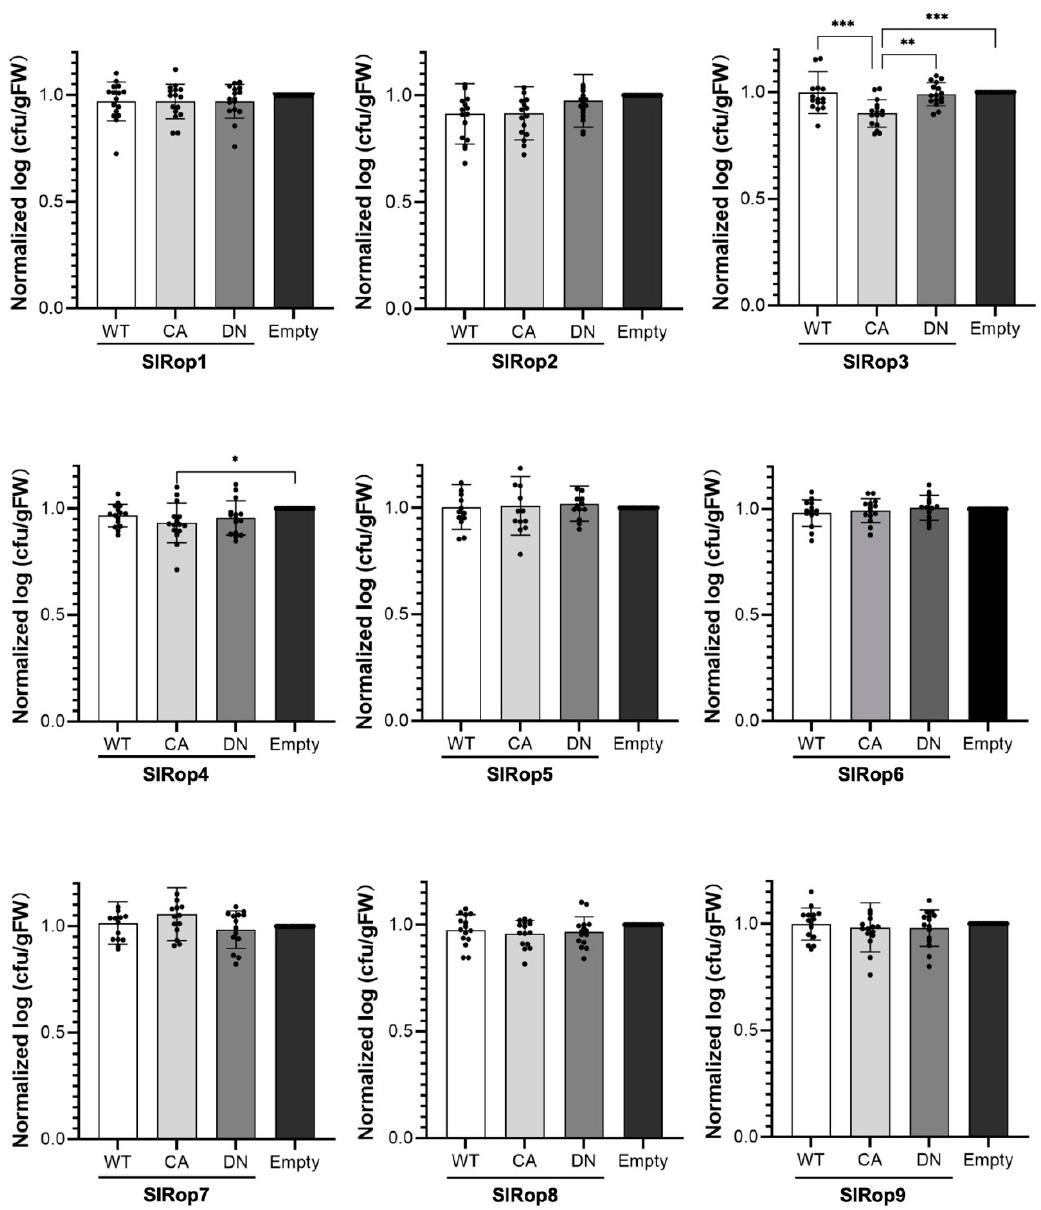
Figure 7. Contribution of SlRop1–9 to defense against R. solanacearum. Effects of tomato ROPs on the virulence of R. solanacearum in N. benthamiana . The R. solanacearum Y45 strain was injected into the regions overexpressing different activation states of 35S promoter-driven SlRop1–9. By 2 dpi, the extractions from inoculated leaves were spread on the medium. The number of bacteria towards plant fresh weight was calculated and then converted to a logarithmic scale. Bars indicate the growth of Y45 relative to that determined in negative control Empty. WT, wild type; CA, constitutively active; DN, dominant-negative; Empty, empty vector. Data are expressed as means ± SD (one-way ANOVA; * p < 0.05; ** p < 0.01; *** p < 0.001). The relative replication of bacteria (Empty = 1) is shown. Black dots in the charts indicate each normalized value including biological and technical replicate. The independent experiments were repeated at least three times.